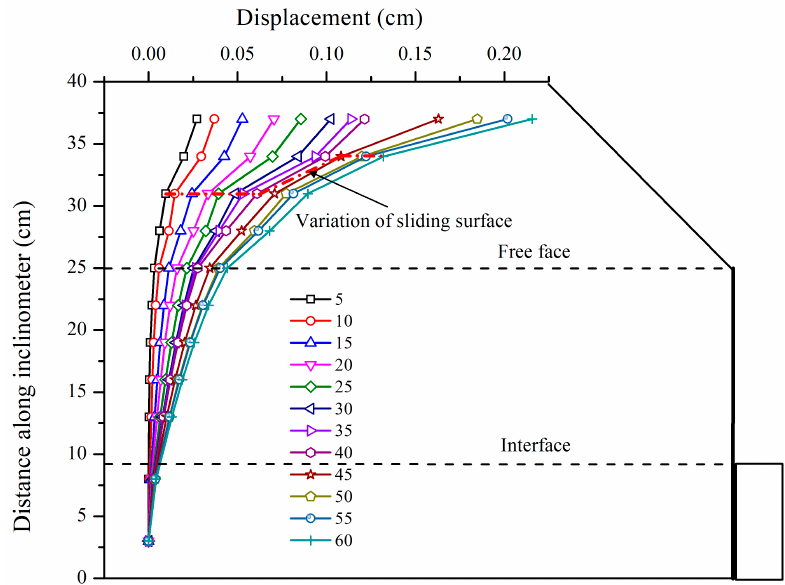
Figure 10. Displacement of inclinometer pipe for centrifugal forces ranging from 5 g to 60 g.